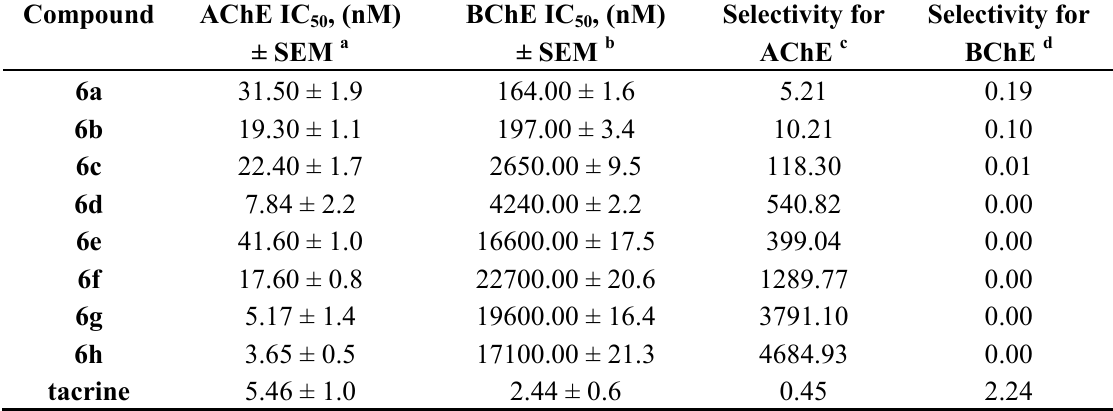
Table 1. IC values for activities towards acetylcholinesterase (AChE) and 50 butyrylcholinesterase (BChE). Compound Selectivity for Selectivity for